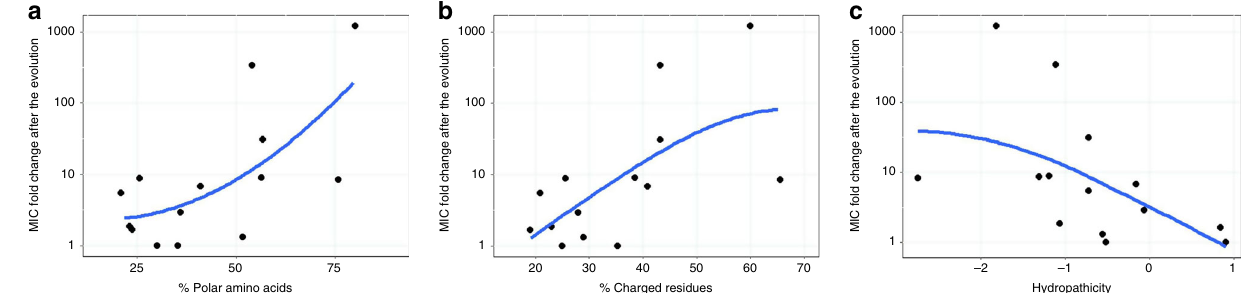
Fig. 2 Resistance level correlate with AMPs ’ physicochemical features. Each datapoint shows the average MIC-fold change in laboratory evolved E. coli K-12 BW2511 lines exposed to one of each 14 AMPs. a Fraction of polar amino acids and relative resistance level (Spearman ’ s rho = 0.58; p = 0.03, N = 14). b Fraction of positively charged and relative resistance level (Spearman ’ s rho = 0.62; p = 0.02, N = 14). c AMP hydropathicity and relative resistance level (Spearman ’ s rho = − 0.73; p = 0.002, N = 14). For AMP properties, see Supplementary Data 3. Blue lines indicate the curve fi tted using LOESS smoothing method in R. Source data are provided as a Source Data fi cost (Supplementary Fig. 1, Spearman ’ s rho = − 0.24, P = 0.016 ( N = 98)), and this correlation becomes non-signi fi cant after controlling for drug type ( P = 0.6 and P = 0.39 for antibiotics ( N = 60) and AMPs ( N = 38) respectively, Spearman ’ s correlation).